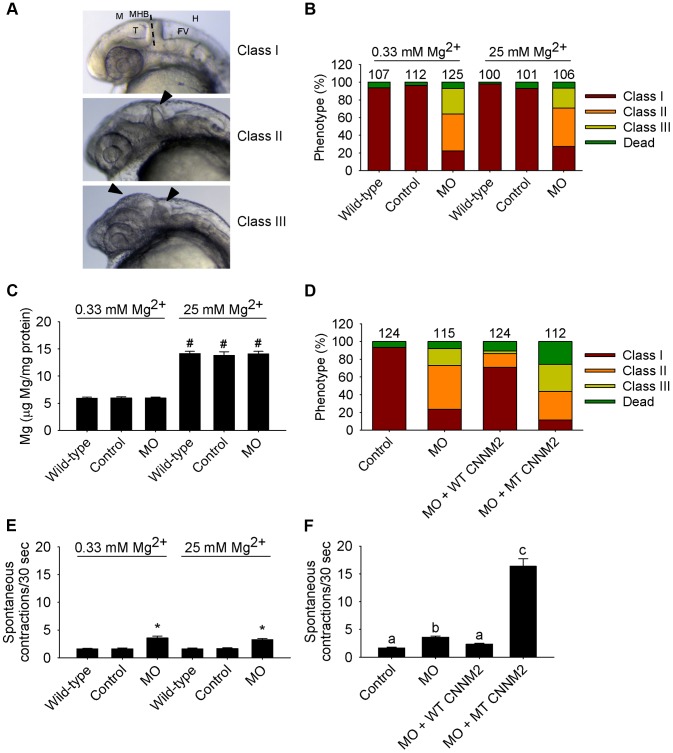
Dysfunctional cnnm2b causes brain abnormalities and increased spontaneous contractions in zebrafish embryos (25 hpf).(A) Phenotypes in zebrafish embryos untreated (wild-type) or following treatment with cnnm2b-MO (8 ng MO/embryo) or control-MO. See Figure 6 for an explanation of the abbreviations shown. (B) Distribution of phenotypes and (C) Mg content (n = 10 per experimental condition) in zebrafish embryos untreated (wild-type) or injected with 8 ng of cnnm2b-MO or control-MO and exposed to a medium with a concentration of Mg2+ of 0.33 or 25 mM. Numbers on top of the bars indicate the number of animals in each experimental condition. (D) Restoration of normal brain development by co-injection of cnnm2b-MO (8 ng MO/embryo) with cRNA encoding for wild-type (WT) CNNM2 (50 pg cRNA/embryo), and not by co-injection with cRNA encoding for mutant (MT, p.Glu357Lys) CNNM2 (50 pg cRNA/embryo). (E) Spontaneous contractions in zebrafish embryos untreated (wild-type) or injected with 8 ng of cnnm2b-MO or control-MO and exposed to a medium with a concentration of Mg2+ of 0.33 or 25 mM (n = 30 per experimental condition). (F) Restoration of normal spontaneous contraction activity (n = 30 per experimental condition) by co-injection of cnnm2b-MO (8 ng MO/embryo) with cRNA encoding for wild-type (WT) CNNM2 (50 pg cRNA/embryo), and not by co-injection with cRNA encoding for mutant (MT, p.Glu357Lys) CNNM2 (50 pg cRNA/embryo). Data are presented as mean ± SEM. *P<0.05 versus wild-type and control. #
P<0.05 versus Mg2+-normal (0.33 Mm Mg2+) medium. Data are presented as mean ± SEM. Different letters indicate significant differences between mean values in experimental groups (P<0.05).